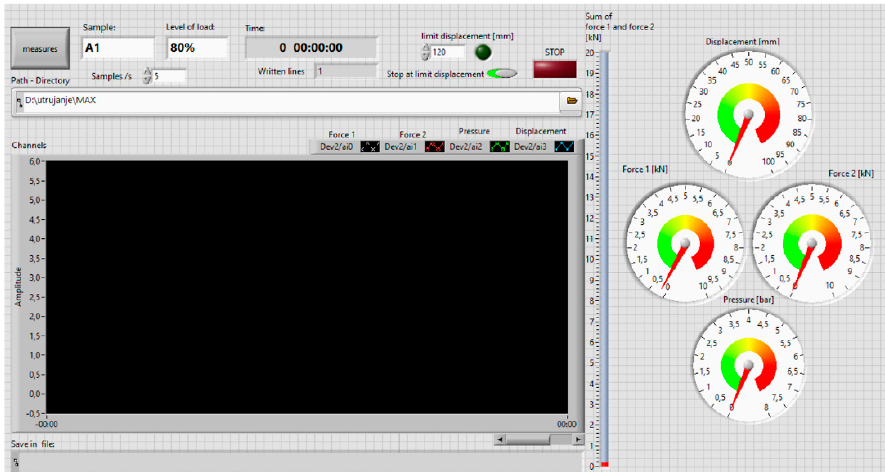
Figure 12. Software interface.